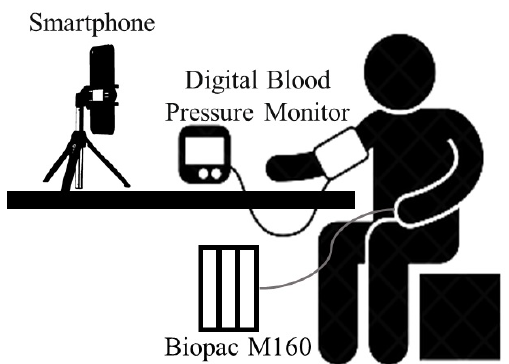
Figure 4. Devices and setup used to collect MPM-BP.